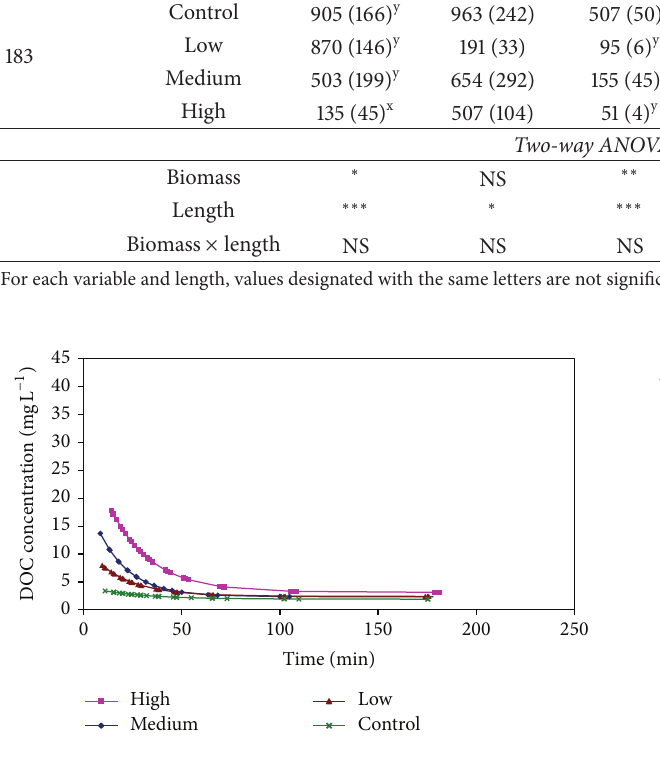
Figure 4: The DOC concentration at the 91m location. The labels High, Medium, Low, and Control refer to the amount of residue biomass in the furrow.